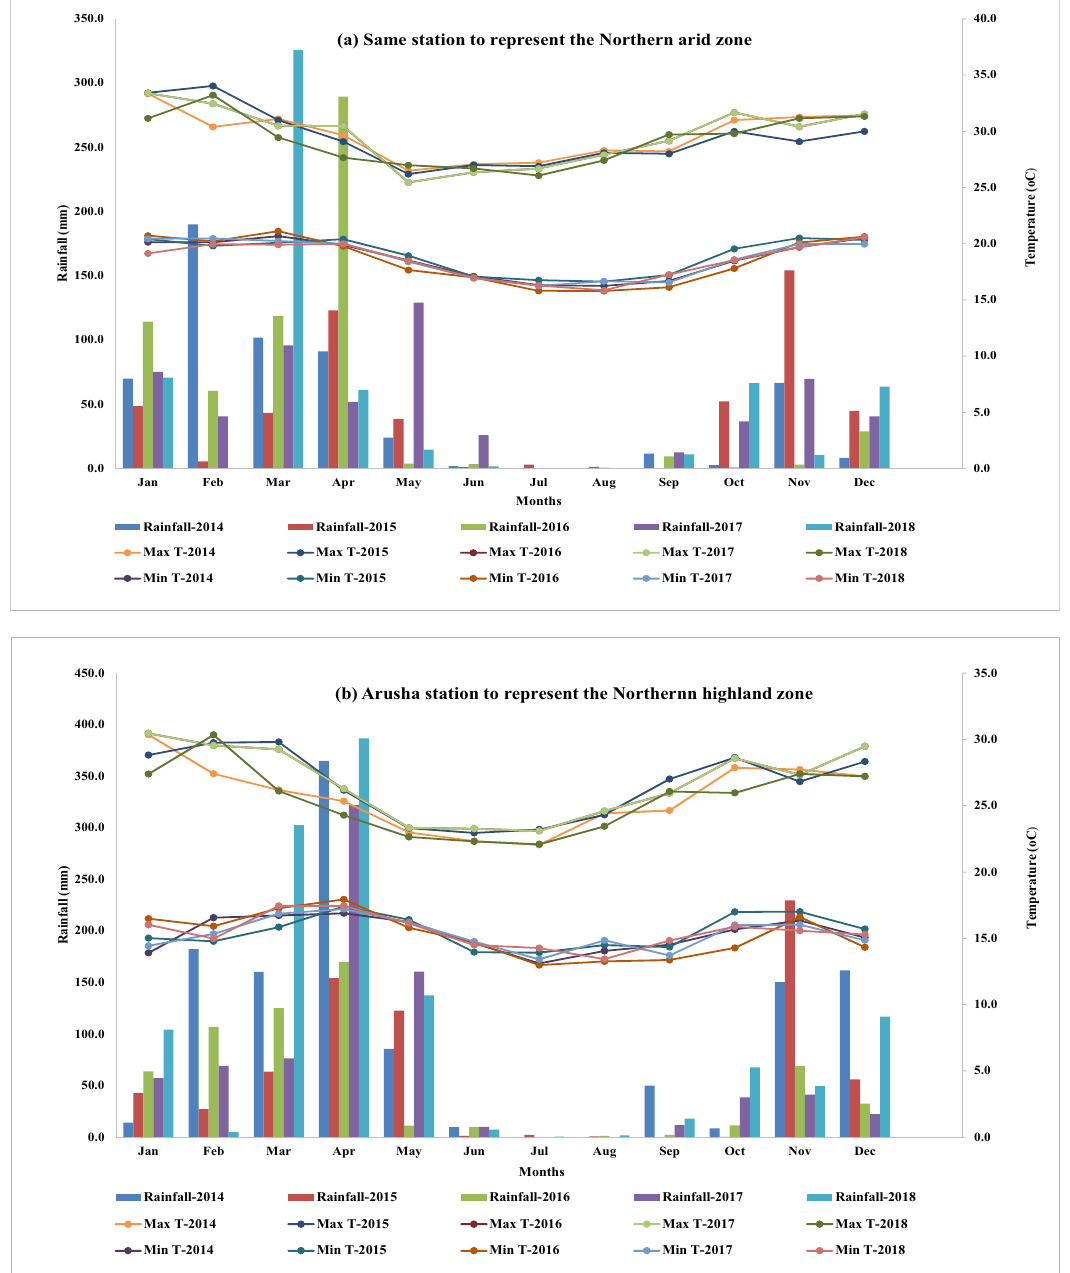
Figure 6: ( a ) Weather data showing the trends in rainfall ( mm ) and maximum and minimum temperatures ( °C ) in the Northern arid zone for a period of 5 years ( 2014 – 2018 ) as represented from Same station; June – August were established as the driest months. ( b ) Weather data showing the trends in rainfall ( mm ) and maximum and minimum temperatures ( °C ) in the Northern highland zone for a period of 5 years ( 2014 – 2018 ) as represented from Arusha station; June – August were established as the driest months. ( c ) Weather data showing the trends in rainfall ( mm ) and maximum and minimum temperatures ( °C ) in the Central zone for a period of 5 years ( 2014 – 2018 ) as represented from Dodoma station; June – October were established as the driest months. ( d ) Weather data showing the trends in rainfall ( mm ) , maximum and minimum temperatures ( °C ) in the Eastern zone for a period of 5 years ( 2014 – 2018 ) as represented from Kilosa station; Mid - June – September were established as the driest months. ( e ) Weather data showing the trends in rainfall ( mm ) and maximum and minimum temperatures ( °C ) in the Coastal zone for a period of 5 years ( 2014 – 2018 ) as represented from Handeni station; June – August were established as the driest